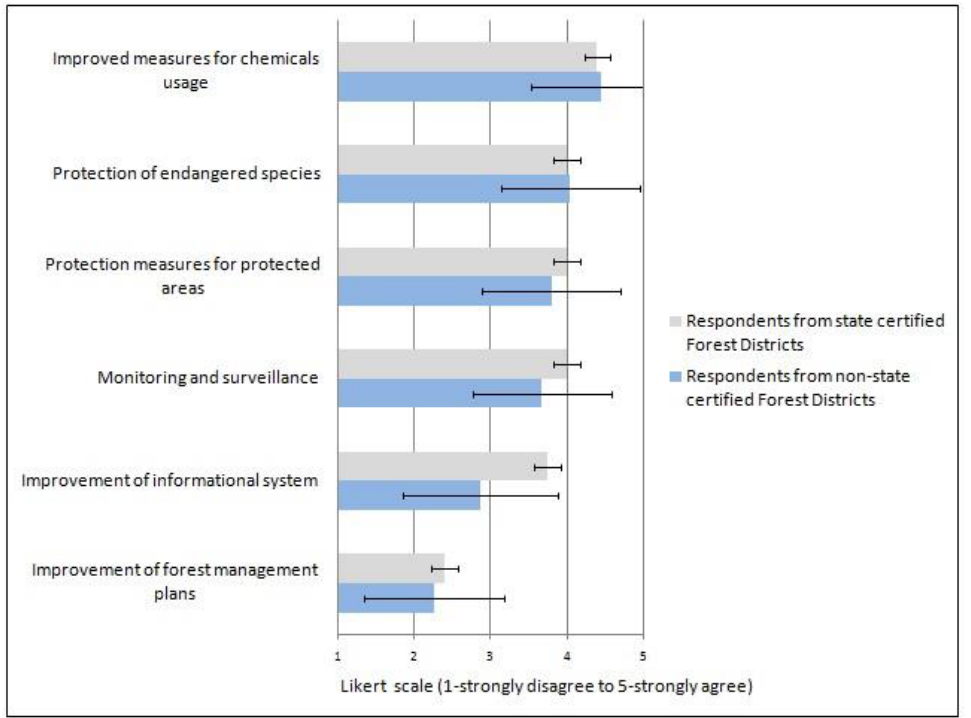
Figure 5. FDs FSC responsible persons perception over the changes brought to forest management by FSC forest management certification (Likert scale question: Indicate, on a scale from 1 to 5, the improvements determined by FSC certification on the analyzed aspects (in Supplementary)).